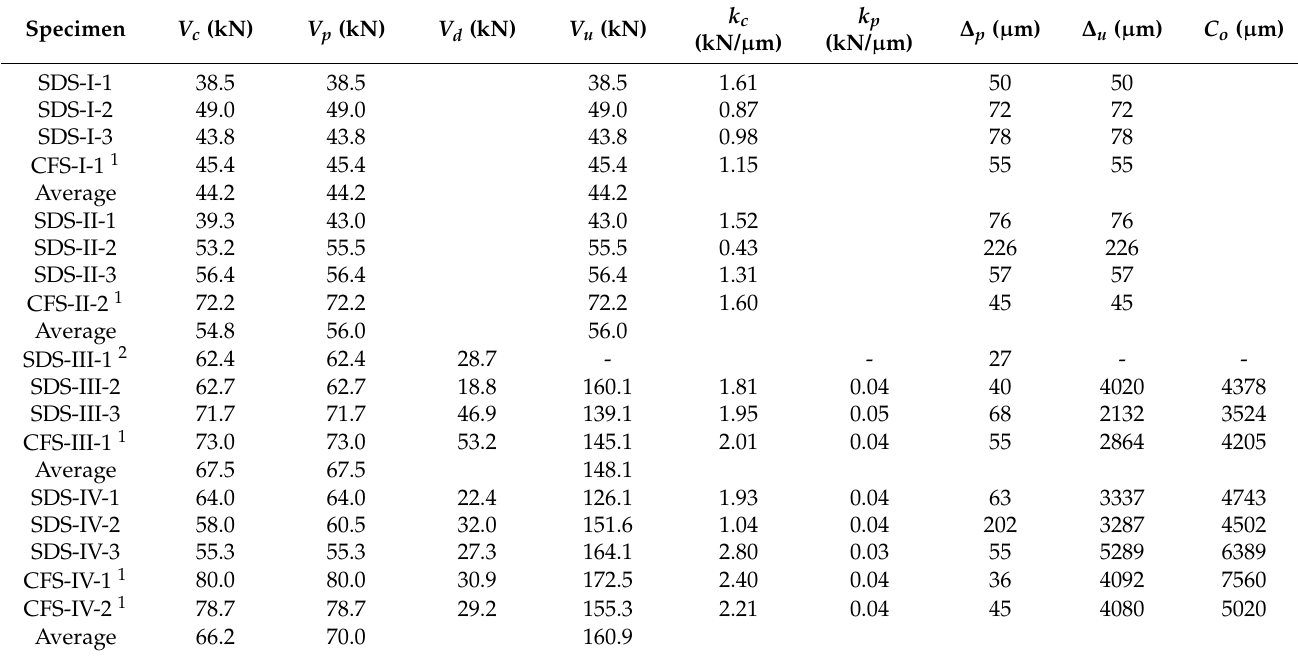
Table 2. Results of SDS test.